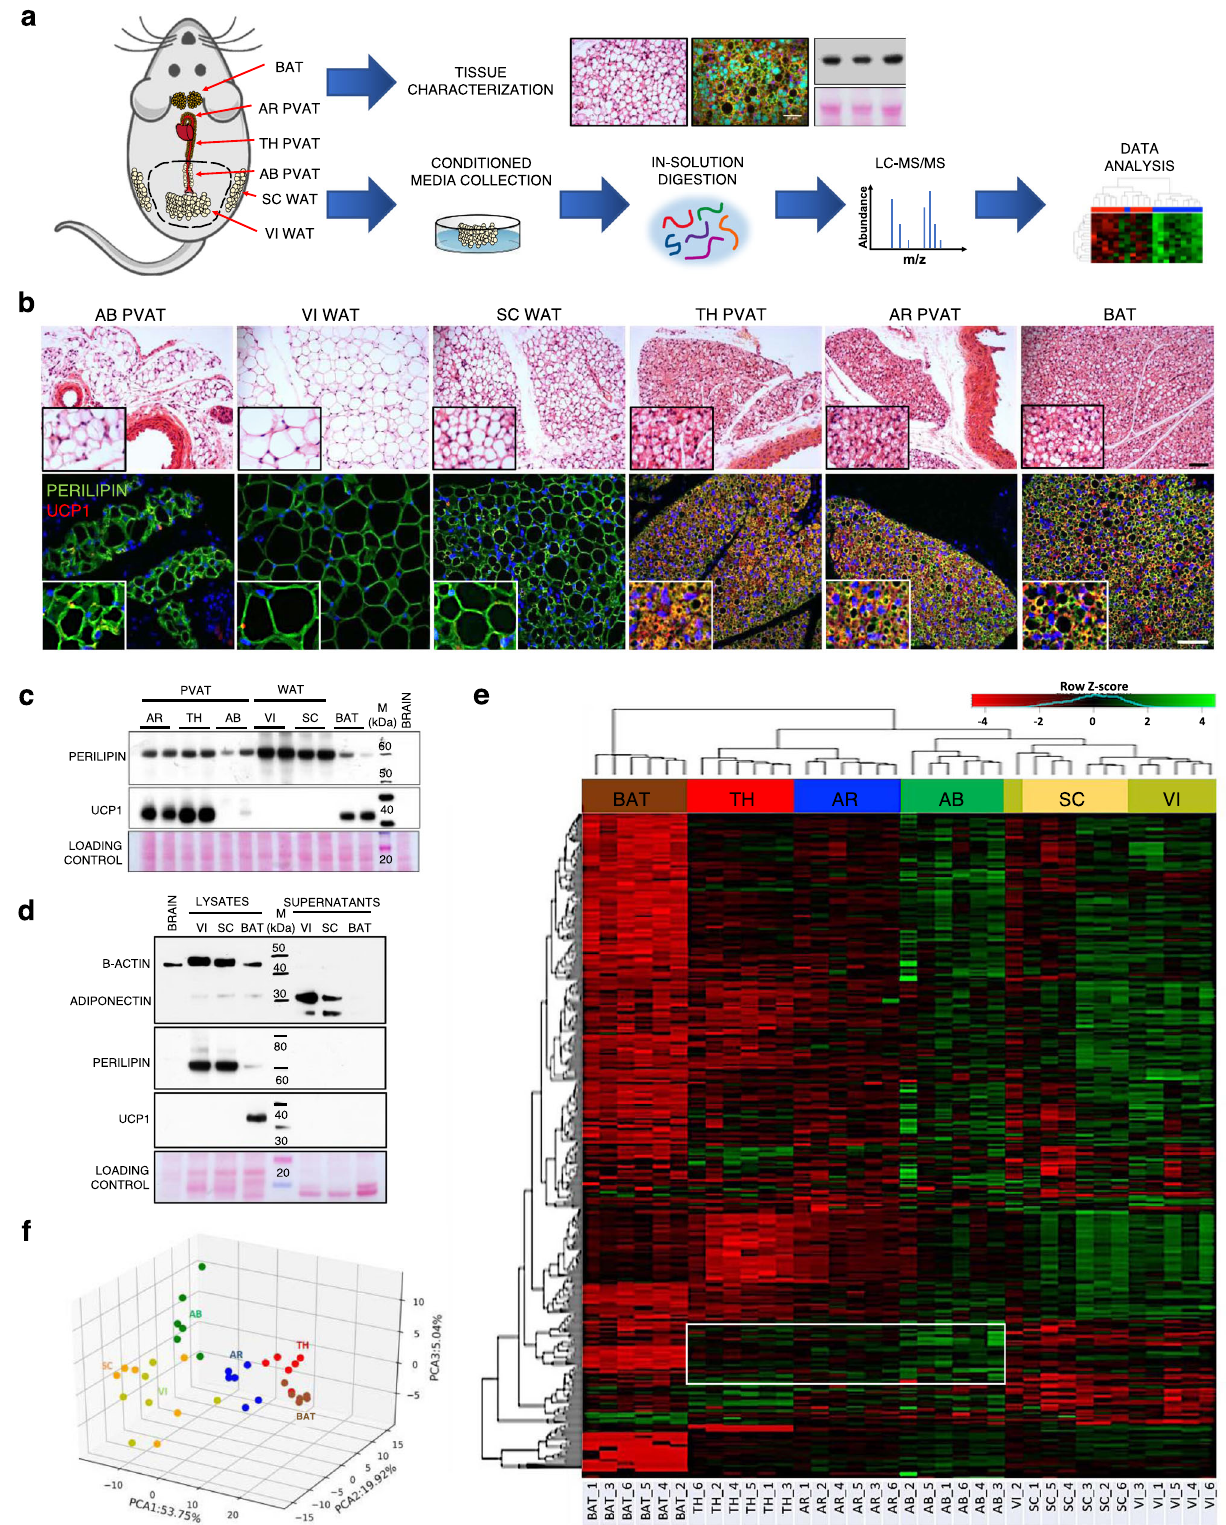
suggesting that a higher number of neuronal projections is a de fi ning feature of PVAT depots. This was con fi rmed by immunostainings (Fig.2h).PVATfromAR andTHregionsdisplayedadenserdistribution pattern of sympathetic arborisations with respect to all other AT samples. An exception, however, was the AB PVAT: the greater abun- dance of tyrosine hydroxylase detected in protein extracts was